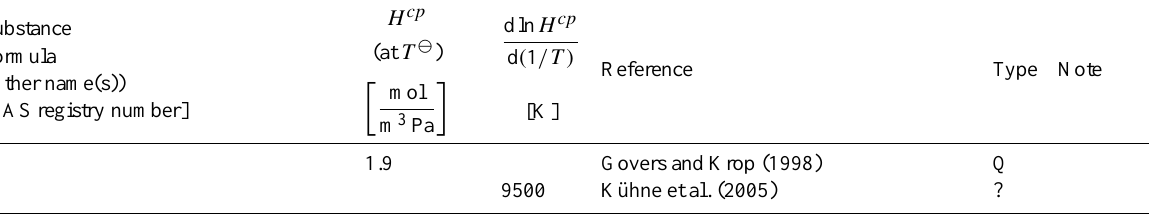
Table 6: Henry’s law constants for water as solvent